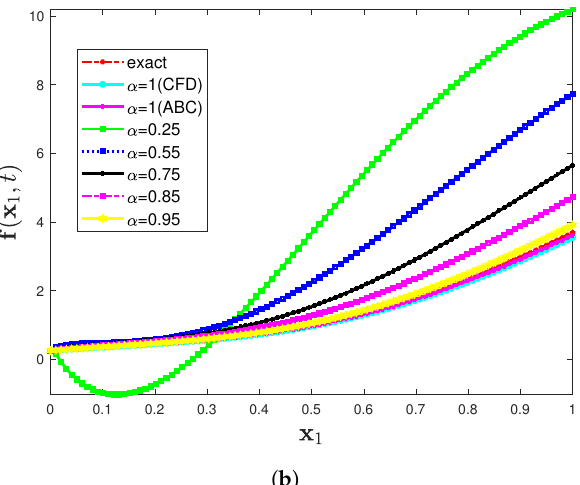
Figure 6. ( a ) Three-dimensional comparison plot among exact, CFD, and ABC fractional derivative operators via the IETM ( b ) Two dimensional representation of f ( x 1 , ¯ t ) for Problem 2 when the parameters are θ = 6, β = 1, and ϕ =